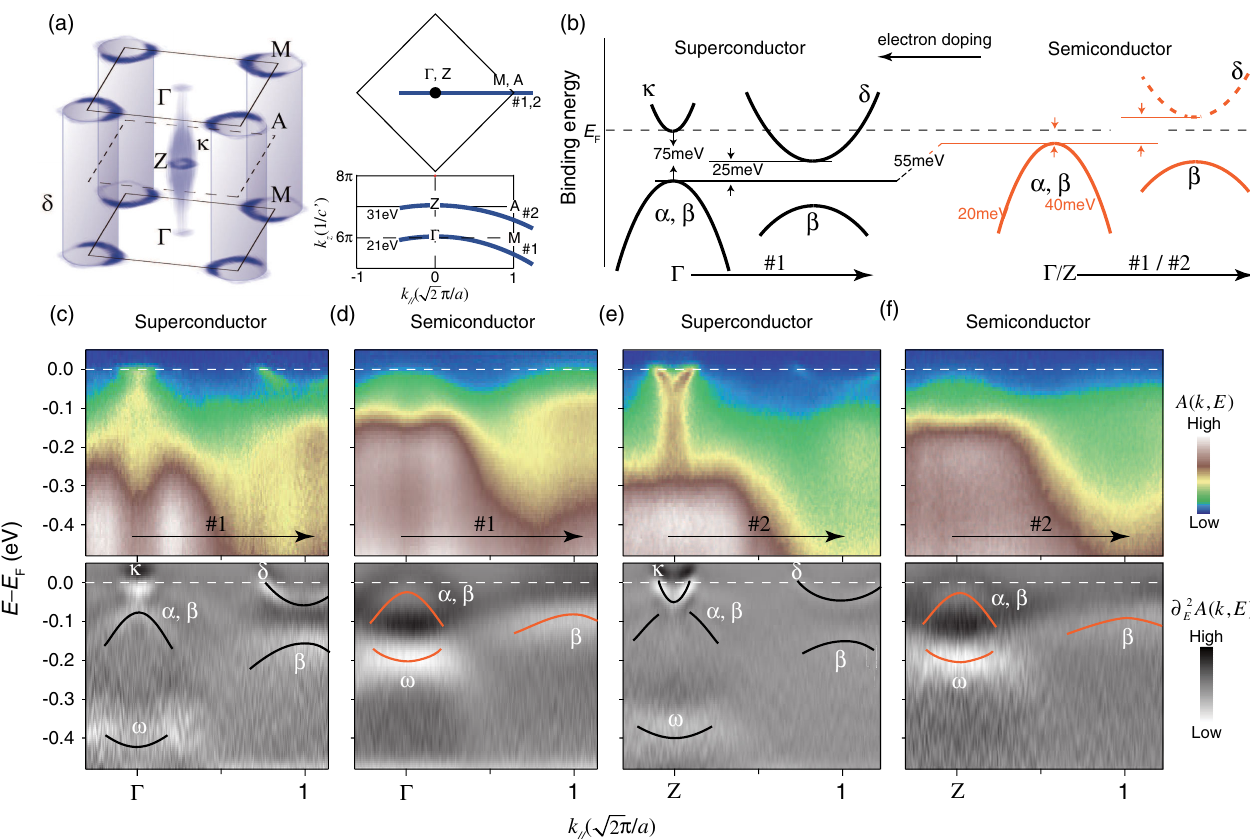
FIG. 4. Low-energy electronic structures of the superconducting and semiconducting K x Fe 2 (cid:1) y Se 2 . (a) Left: the Fermi surface of the superconducting phase in the 3D Brillouin zone. Right: the two-momentum cut #1 and cut #2 sampled with 21 eVand 31 eV photons, respectively, are illustrated in the two-dimensional cross-sections of the 3D Brillouin zone. c 0 is the distance between neighboring FeAs layers, and a is the Fe-Fe distance in the FeAs plane. (b) A sketch of the band-structure evolution from the semiconductor to the superconductor. (c) The photoemission intensities (upper panel) and their second derivatives with respect to energy (lower panel) along cut #1 across (cid:2) for the superconductor taken at 35 K. (d) is the same as (c) but for the semiconductor taken at 100 K. (e) and (f) are same as (c), (d), respectively, except the data were taken along cut #2 across